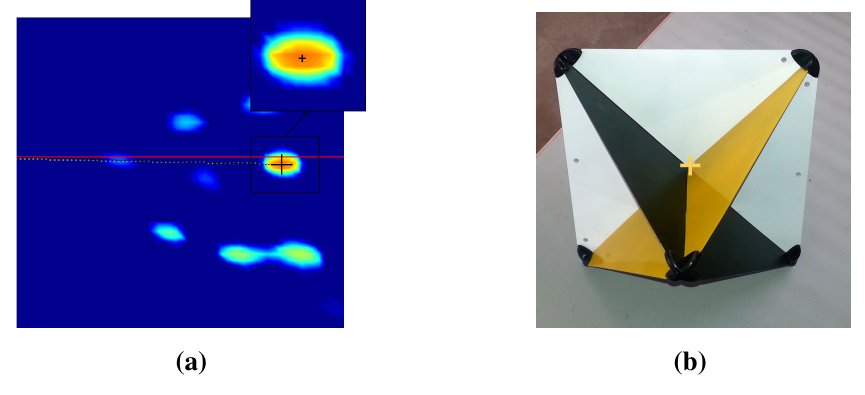
Figure 18. Center detection of targets in both the camera image and radar panoramic.